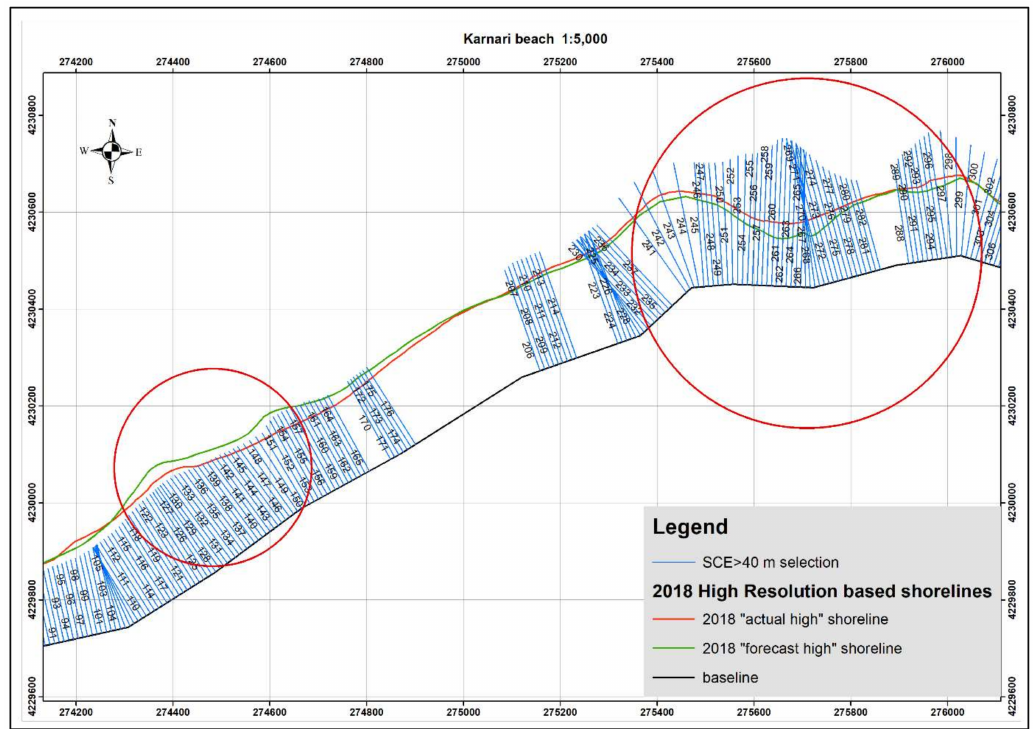
Figure 7. Transects where the SCE rates of the 1945–2008 shorelines based on high-resolution data on the Karnari coast are over 40